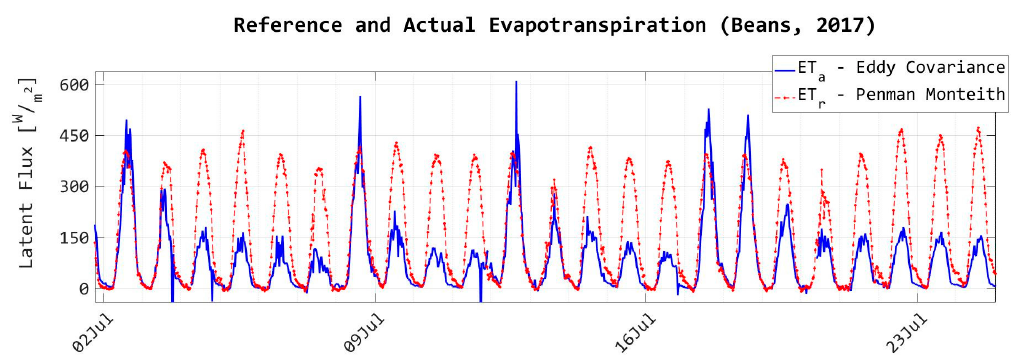
Figure 7. Time series of latent flux at Site 1. The variability in ETa followed the 4 to 5-day irrigation cycle (irrigation occurring on 2 July, 8 July, 12 July, 17 July).